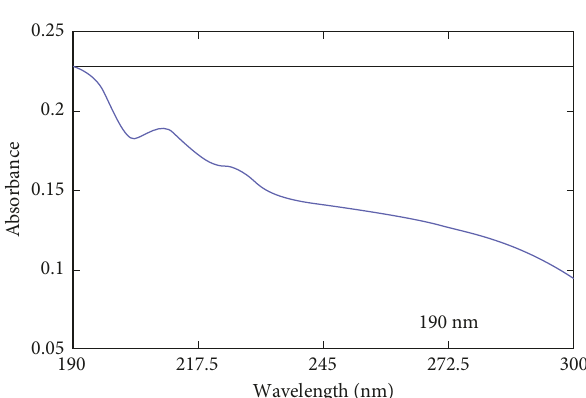
Figure 8: UV-Vis (arcing in DW for 6 min, peak at 190 nm).